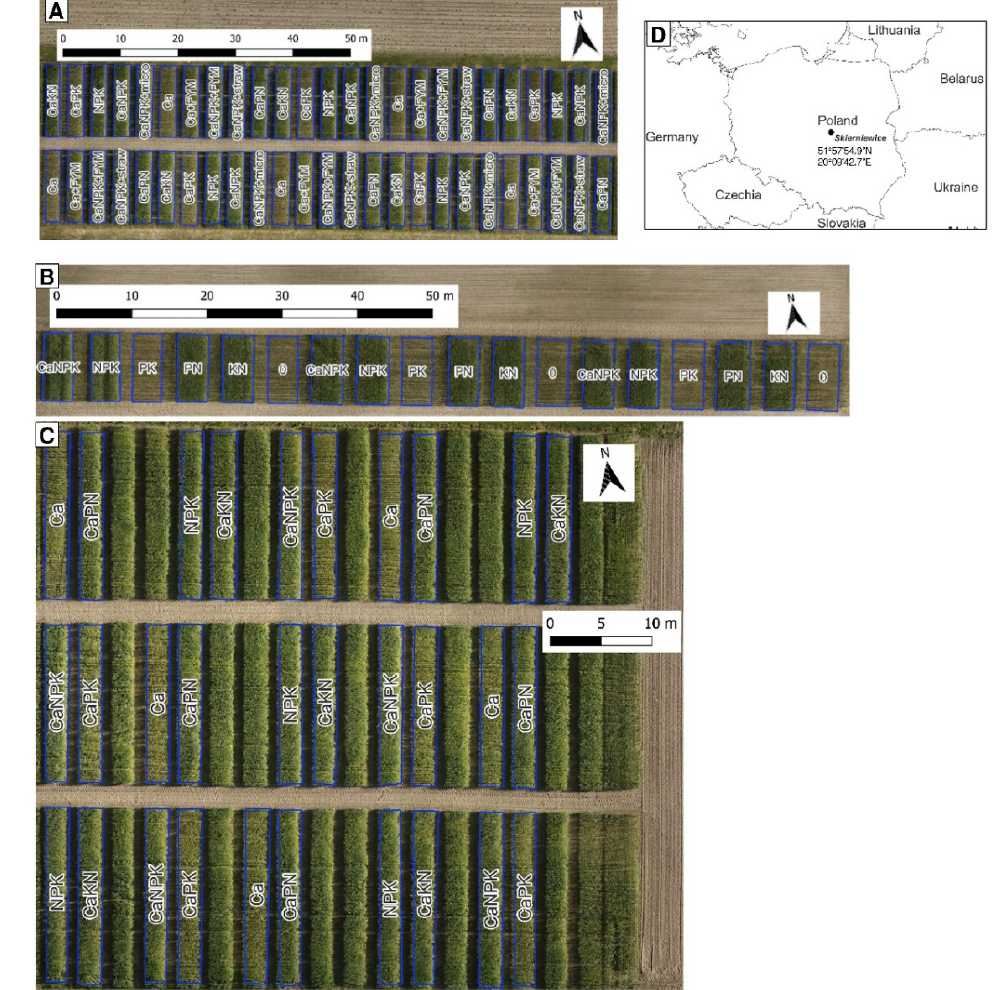
Figure 1. Design of the studied field experiments in the Experimental Station in Skierniewice (borders of the plots, information about the fertilization and RGB ortophotomap from 3 June 2022). ( A )—field experiment 2; ( B )—field experiment 1; ( C )—field experiment 3; ( D )—map presenting location of the FYM—farmyard manure,